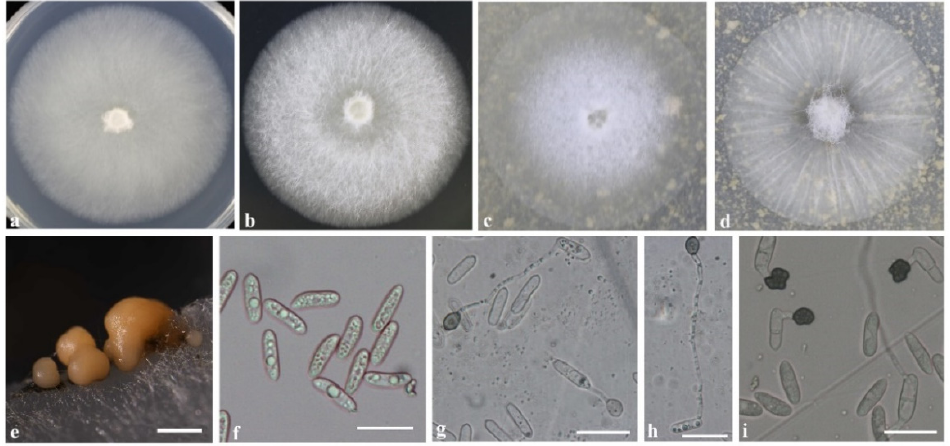
Figure 4. Culture characteristics and microscopic features of C. fructicola . ( a , b ) Seven-day-old of colonies on PDA and MEA medium, respectively. ( c , d ) Seven-day-old of colonies on OA medium. ( e ) Conidiomata on PDA medium. ( f ) Conidia. ( f – i ) Appressoria. Scale bars: ( e ) = 500 μ m; ( f – i ) = 20 μ m. ( a–c , e – h ): isolate GT-22; ( d , i ): isolate JH-2.